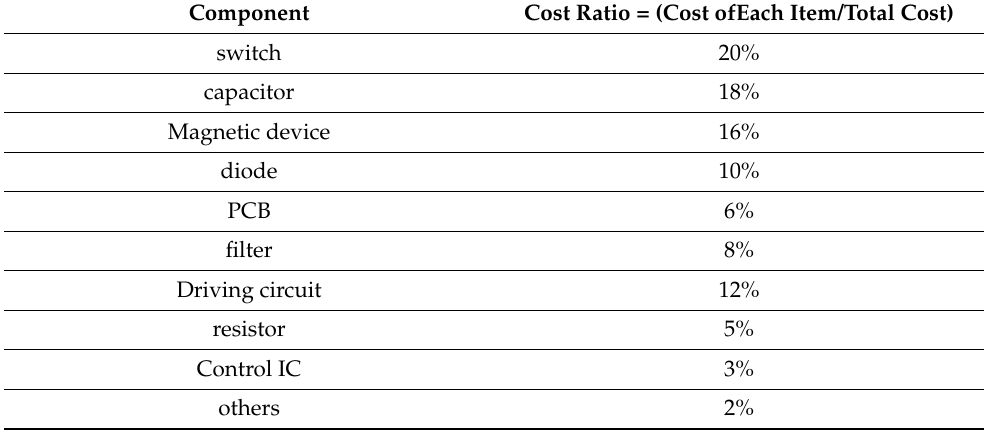
Table 1. Total cost analysis of switching power supply (data from Industrial Economics and Knowl- edge Center (IEK) in Taiwan).